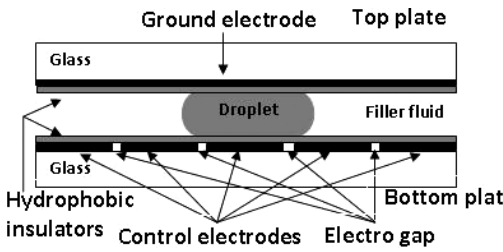
Fig. 1. Structure of a